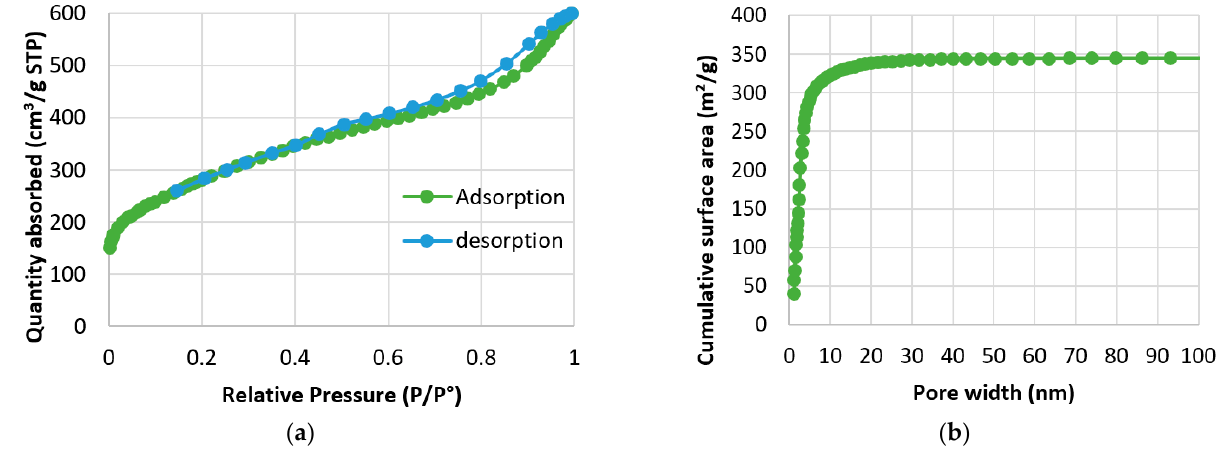
Figure 5. ( a ) Nitrogen adsorption/desorption isotherms; ( b ) pore size distribution with insert in the region of pore diameter between 0 and 100 nm for AC based on argan nutshells. region of pore diameter between 0 and 100 nm for AC based on argan nutshells. Table 3. Textural properties of the activated carbons obtained from argan. Table 3. Textural properties of the activated carbons obtained from